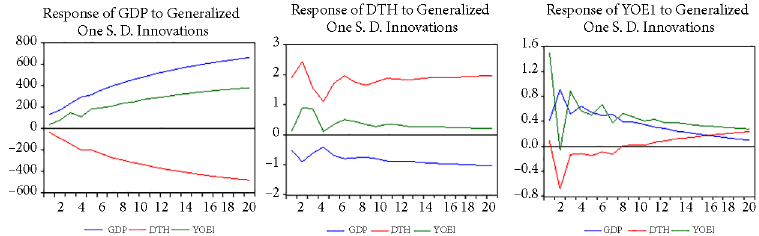
Figure 2. Response of model of Cluster A to Generalized One S.D. Innovations (source: authors ‘own